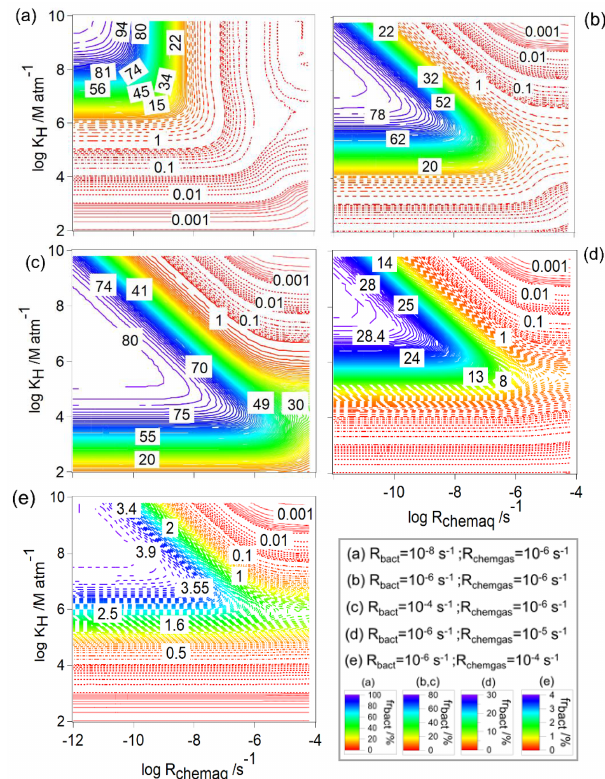
Figure 2. Relative contribution of bacteria to the total loss rate of organics (fr bact , Eq. 7) as a function of R chemaq and K H . All figure panels have the same scales on the ordinates and abscissas. The sim- ulations were performed for constant values of R bact and R chemgas ; their values are indicated in the box at the bottom right.